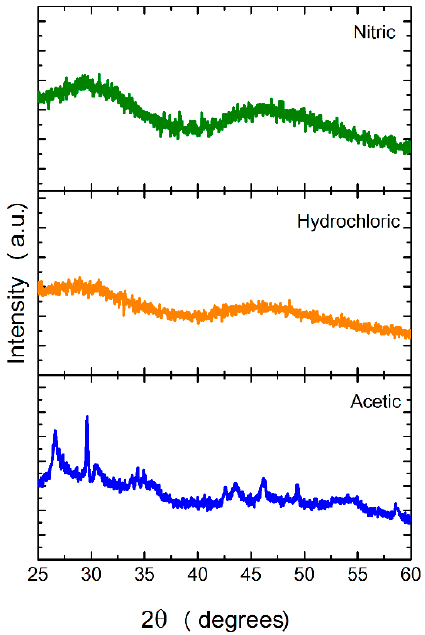
Figure 2. X-Ray diffraction (XRD) diffractograms of nanostructures after microwave synthesis and before any calcination, for the three sets of reactions defined above.